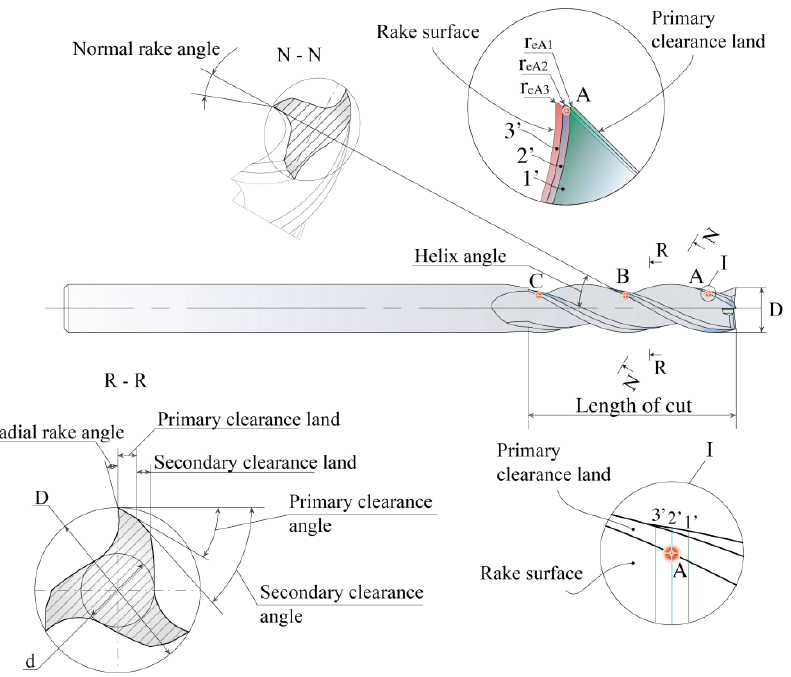
Figure 2. Main geometrical parameters of a solid carbide end micro mill.